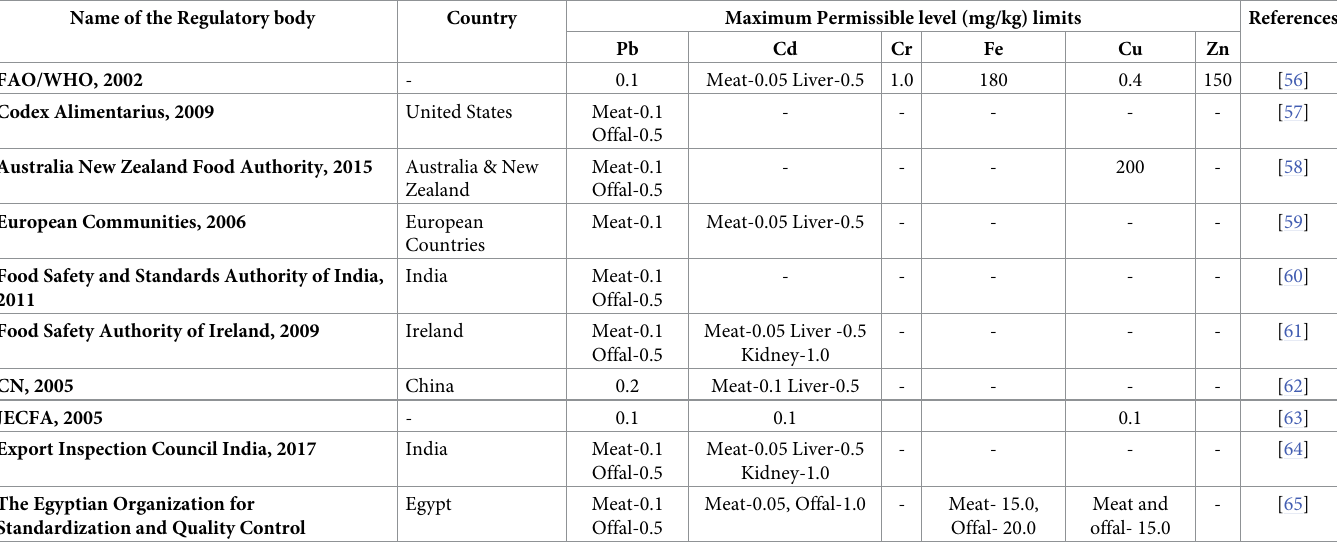
Table 3. Maximum permissible levels (mg/kg) limits in chicken by worldwide regulatory bodies.